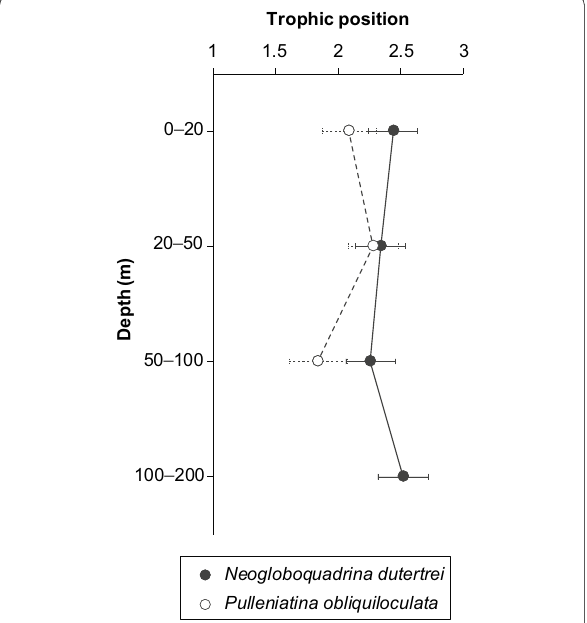
Fig. 6 Trophic position (TP Glu/phe ) of two non-spinose planktonic foraminiferal species ( Neogloboquadrina dutertrei and Pulleniatina obliquiloculata ) along four depth intervals in Suruga Bay, Japan. Error bars indicate the propagation error (potential uncertainly) in TP Glu/Phe calculated in Eq.